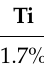
Figure 3. ( a ) X-ray photoelectron spectroscopy (XPS) patterns of the nanoparticles synthesized from the master alloy of Ti–48Al by HPMR in N 2 , H 2 , and Ar atmosphere; ( b – d ) are the enlargements corresponding to different ranges of binding energy. Table 1. Surface composition of the nanopowders. Element